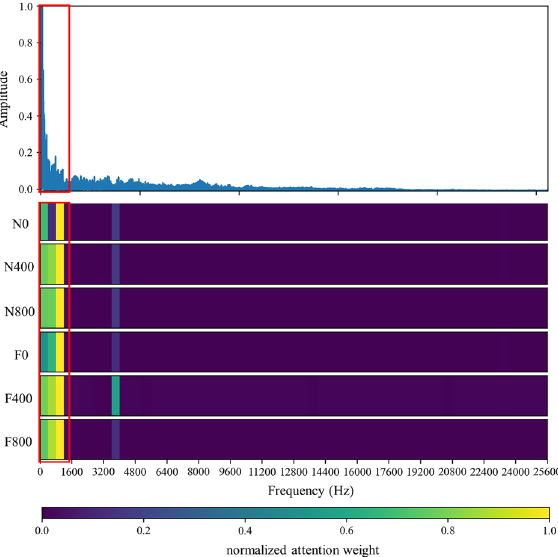
Figure 13. Attention for each working condition on envelope spectrum (25,600 Hz).